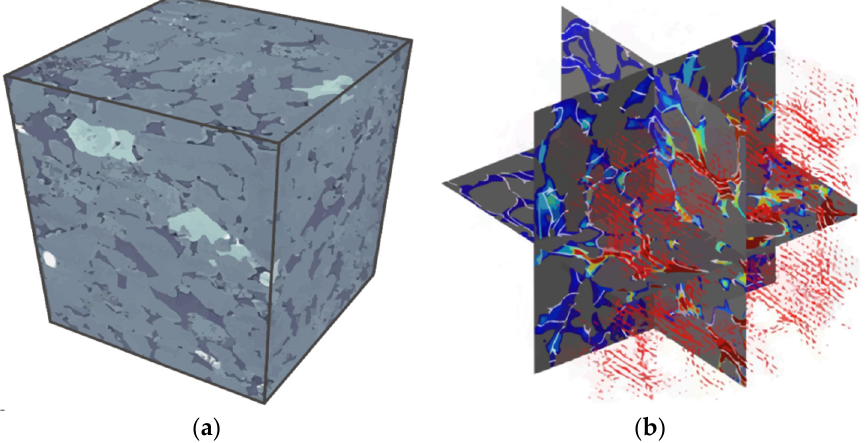
Figure 5. Dense matrix pore network model. ( a ) Matrix block generated by the algorithm, and ( b ) pore network inside the matrix block.